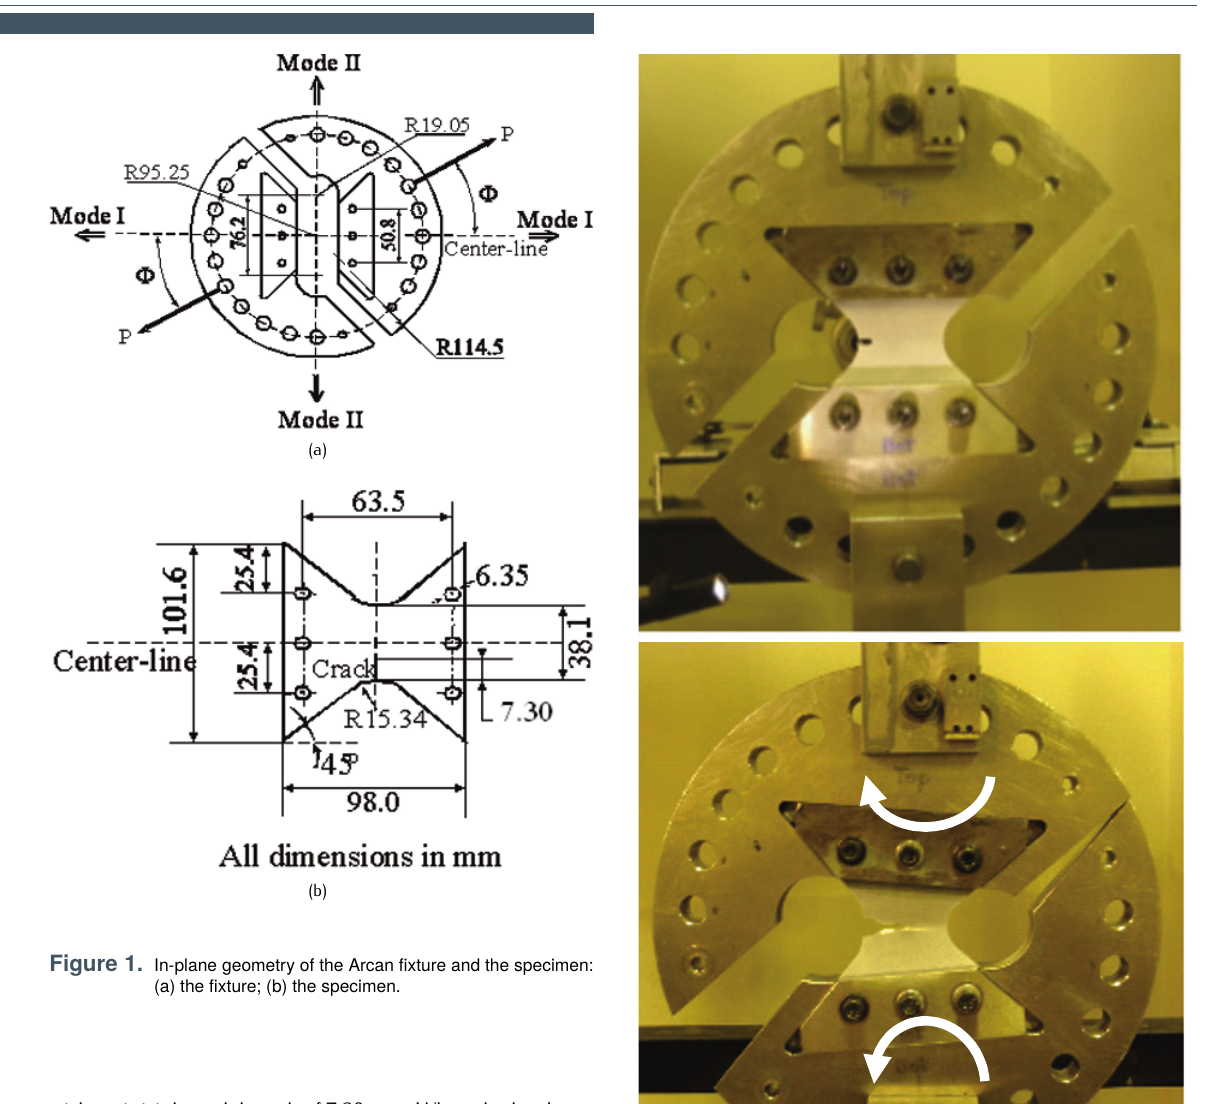
Test Procedure and Results with an initial crack length of 7.30 mm. When the load was applied to the fixture by the attached pin, at the initial stage the actual applied load couldn’t be transmitted to the fixture due to the little slipping, which occurred in the fixture and the pin connection. Table 1 Information for Arcan tests on 2.0mm-thick AL6061T6 specimens